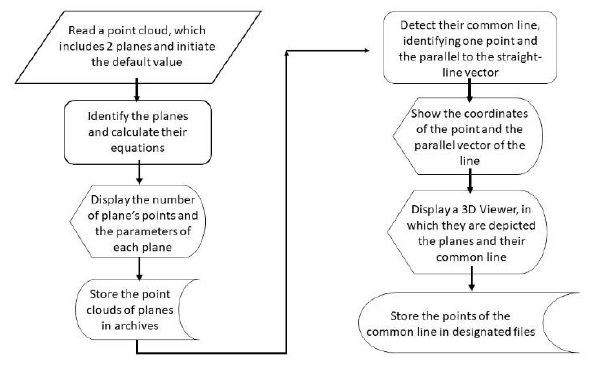
Figure 4. The flowchart of the developed software The first test was carried out in the point cloud of the planes depicted in red in figure 5. The cloud comprised of 76.175 points and the threshold value for the implementation of the RANSAC algorithm was set to 1.2 cm so that the surfaces approach the form of a mathematical surface and in particular that of a plane within that threshold. In this way, it is easier for the algorithm to find the optimal mathematical model of the surface.